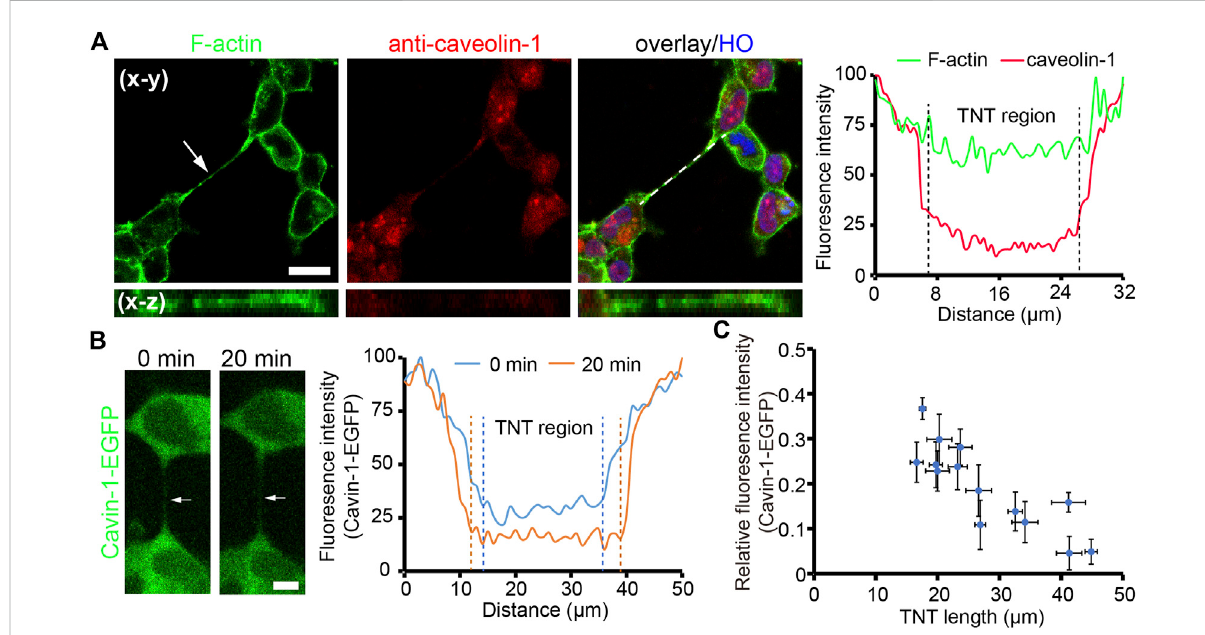
FIGURE 2 Tension of TNT membrane. (A) Localization of caveolin-1 on a TNT (arrow). Caveolin-1 proteins were immunostained with anti-caveolin- 1antibodyandimagedbytheconfocal microscope.Therightpanel shows the fl uorescence intensity pro fi leofcaveolin-1 andF-actin staining along the dashed line. (B) Distribution of cavin-1-EGFP during TNT elongation. The intensity pro fi le demonstrates a reduced abundance of cavin-1-EGFP onaTNT(arrow)whentheTNTelongatedafter20 min. (C) Relative fl uorescenceintensityofcavin-1-EGFPonthecenterofTNTswithdifferent lengths during 25 min live-cell imaging. Scale bars, 10 μ